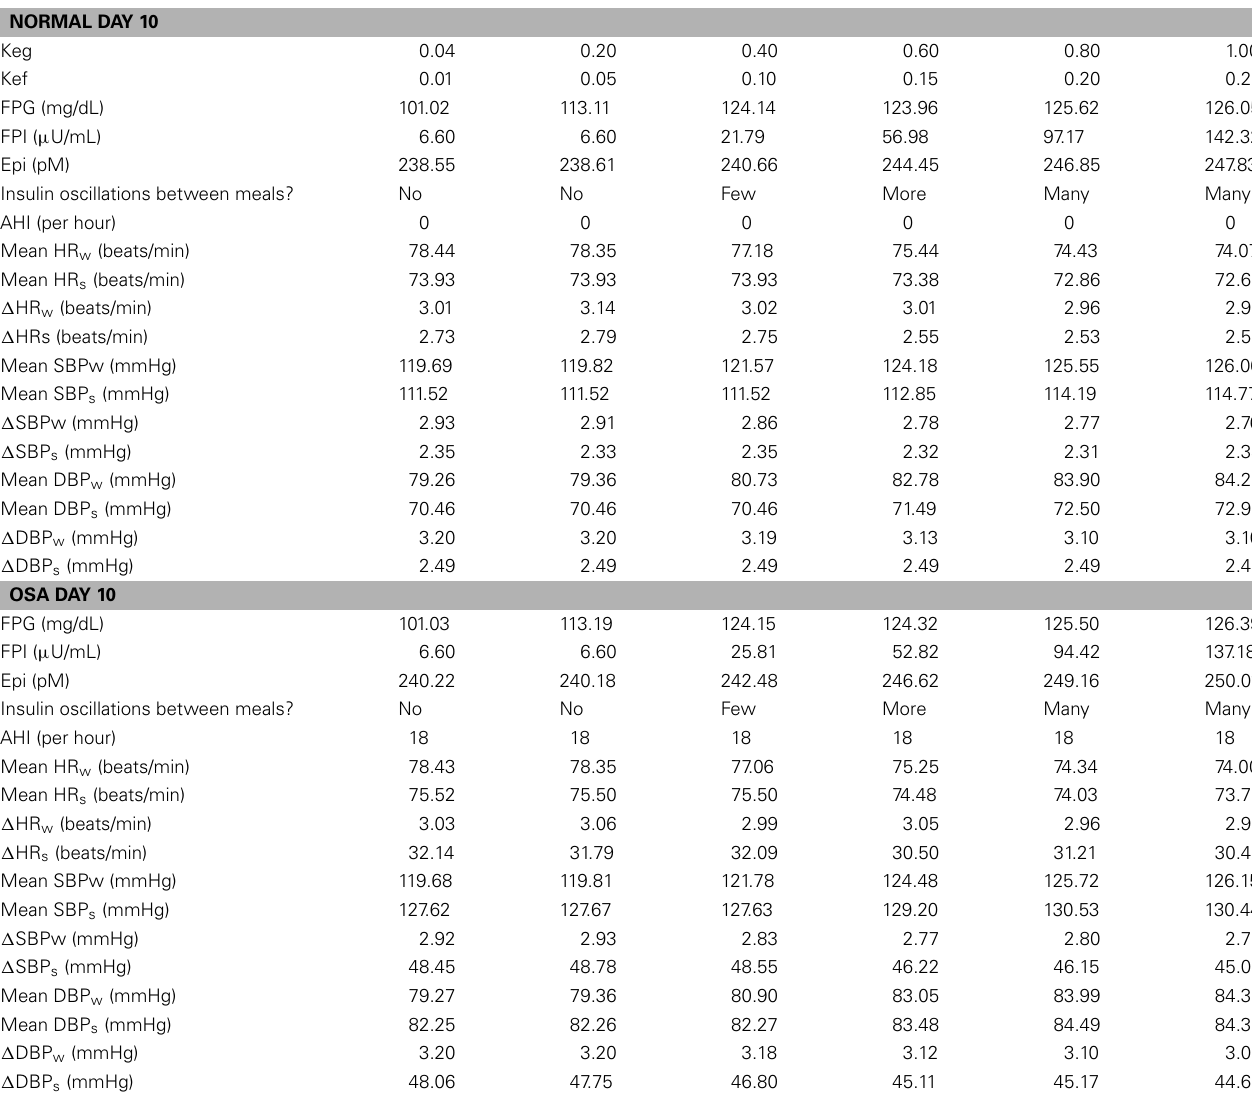
Table 3 | Sensitivity analysis of gains from epinephrine to glucose and FFA that have effects on autonomic and metabolic interactions. NORMAL DAY